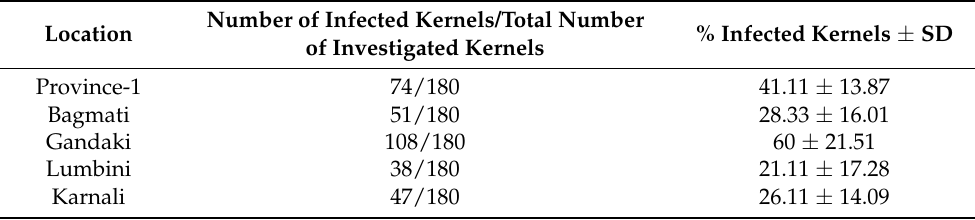
Table 2. Maize kernel mold infection across five different provinces of Nepal.